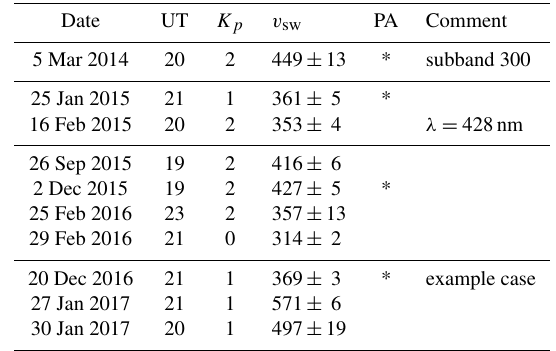
growth-phase arc and the diffuse equatorward emission move southward (i.e. equatorward) leading to the onset and auro- ral breakup. The onset is marked at the point where the local horizontal magnetic field component, B x , deviates by more than 80 nT in 15 min (as per the Tanskanen, 2009,